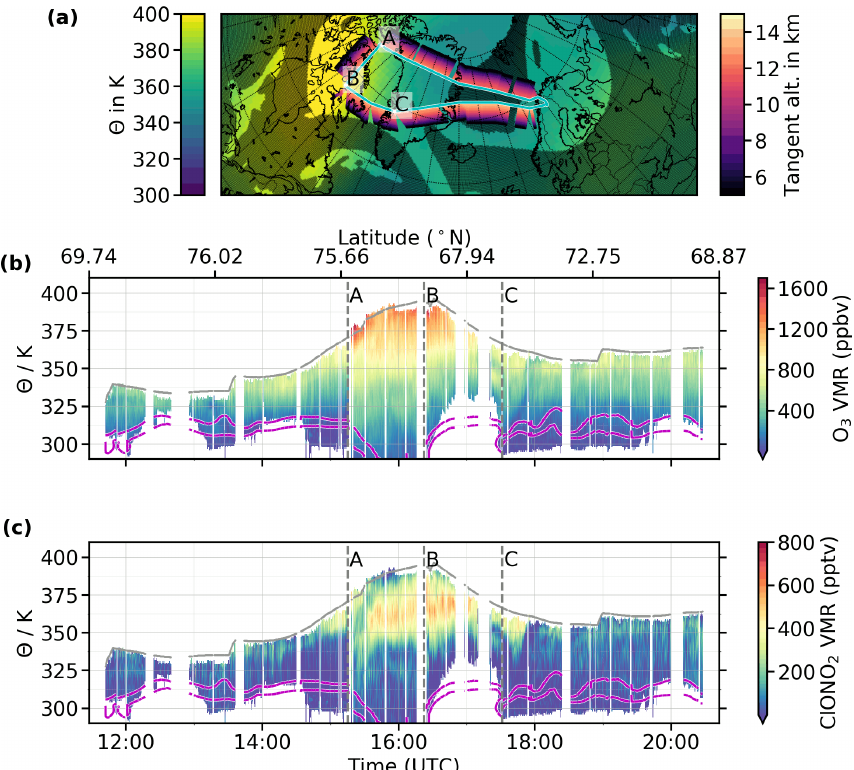
Figure 6. As in Fig. 5 but for flight PGS14 (26 February 2016). The underlain map (bold black lines show coastal lines, regular black lines country borders, and dotted lines indicate a latitude by longitude grid) shows northern Canada, Greenland and northern Europe and is centered at 70 ◦ N latitude and 20 ◦ W